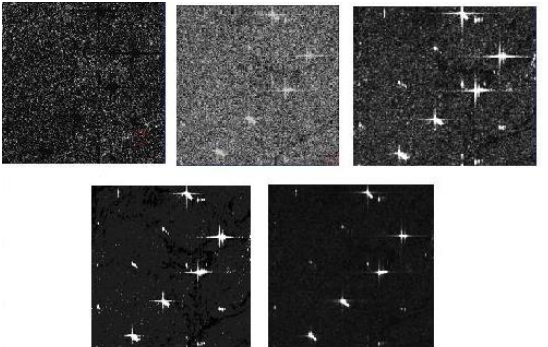
right: skewness, entropy, variance, mean and data range